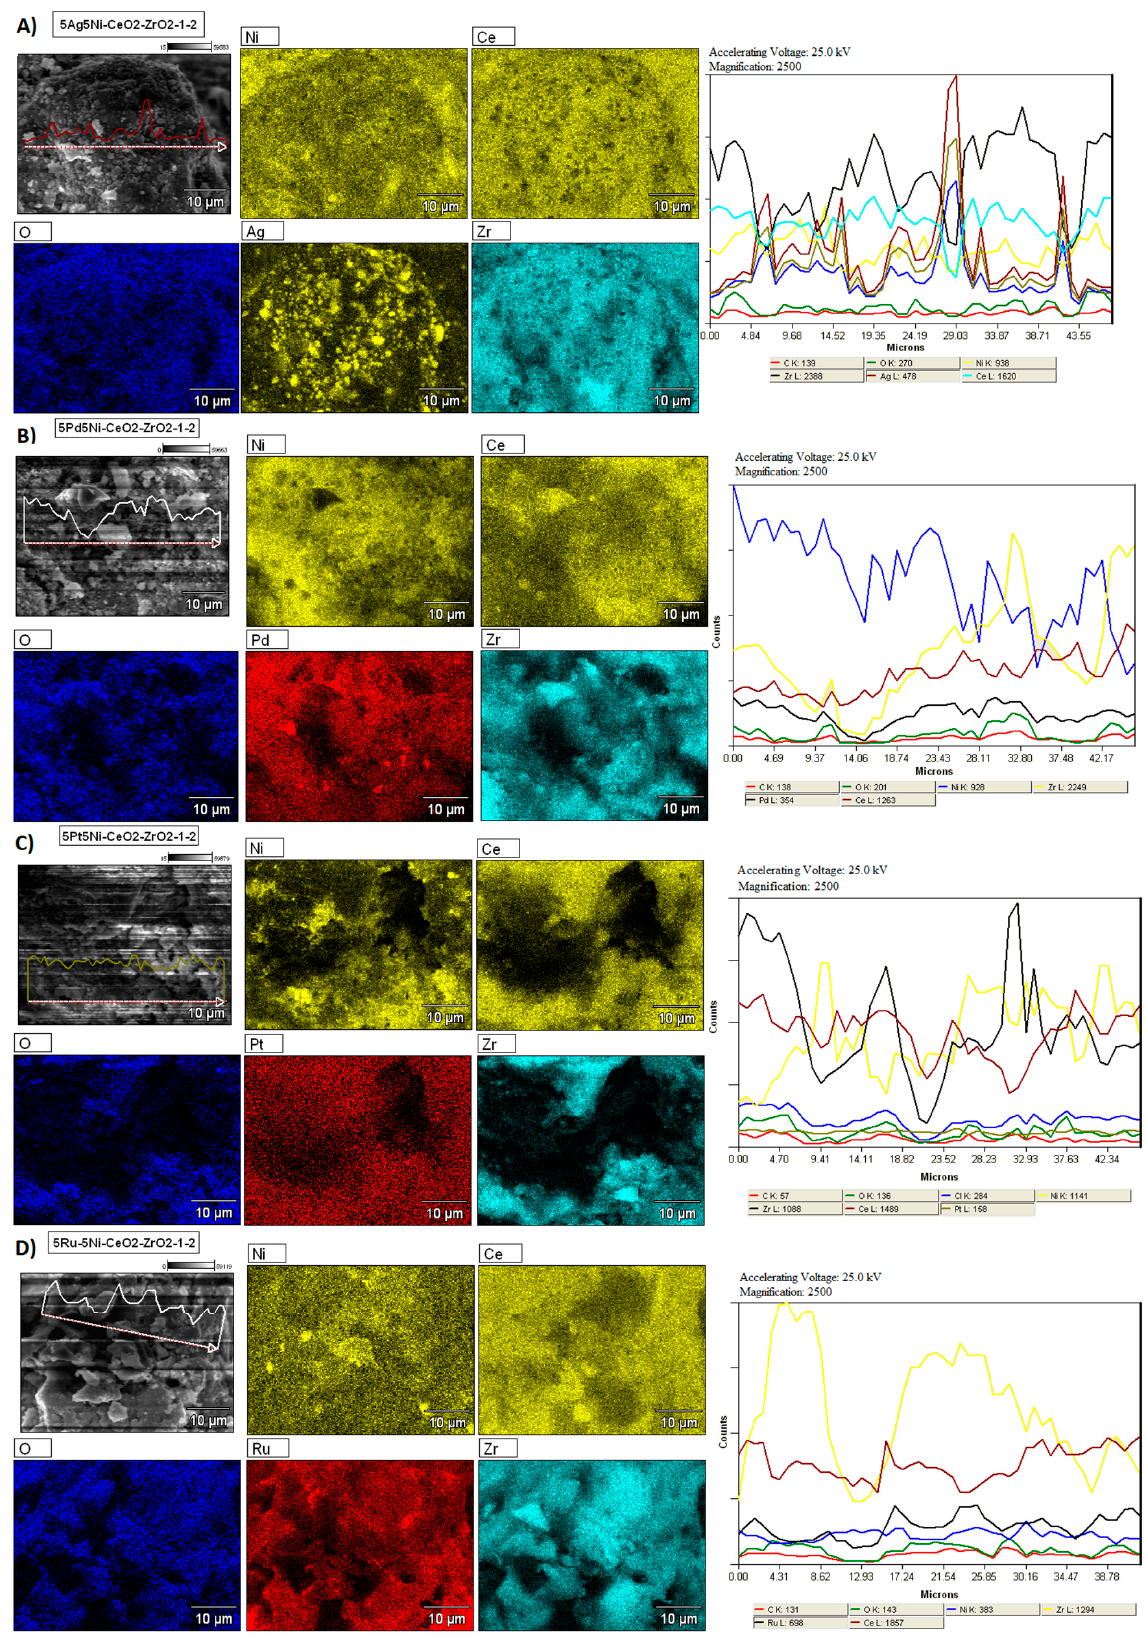
Figure 8. ( A ) SEM image and EDS spectra collected from the marked line analysis recorded for reduced bimetallic 5%Ag ‐ 5%Ni/CeO 2 ∙ ZrO 2 (1:2) catalyst performed in a mixture of 5%H 2 ‐ 95%Ar at 500 °C for 1 h; ( B ) SEM image and EDS spectra collected from the marked line analysis recorded for reduced bimetallic 5%Pd ‐ 5%Ni/CeO 2 ∙ ZrO 2 (1:2) catalyst performed in a mixture of 5%H 2 ‐ 95%Ar at 500 °C for 1 h; ( C ) SEM image and EDS spectra collected from the marked line analysis recorded for reduced bimetallic 5%Pt ‐ 5%Ni/CeO 2 ∙ ZrO 2 (1:2) catalyst performed in a mixture of 5%H 2 ‐ 95%Ar at 500 °C for 1 h; ( D ) SEM image and EDS spectra collected from the marked line analysis recorded for reduced bimetallic 5%Ru ‐ 5%Ni/CeO 2 ∙ ZrO 2 (1:2) catalyst performed in a mixture of 5%H 2 ‐ 95%Ar at 500 °C for 1 h.